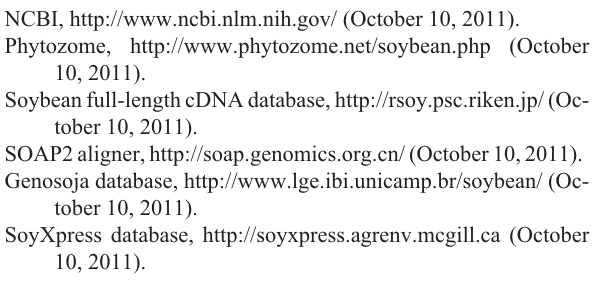
Figure S1 - Perl script to extract information about se- quences from GenBank files. Figure S2 - Perl script to extract the upstream and downstream genomic sequences of the read alignment po-